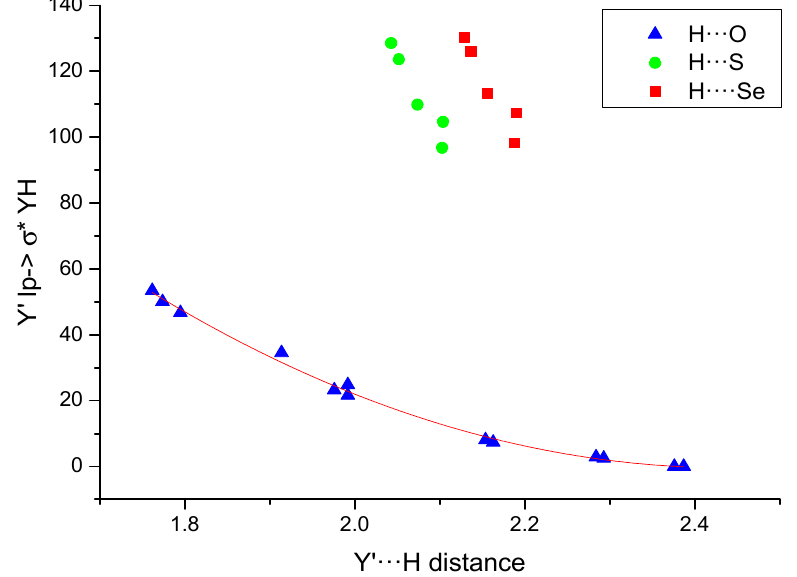
Figure 3. Y’ lp → σ *HY (kJ·mol − 1 ) vs. the Y’···H distance (Å). The fitted second order polynomial curve for the systems with H···O interaction is shown.